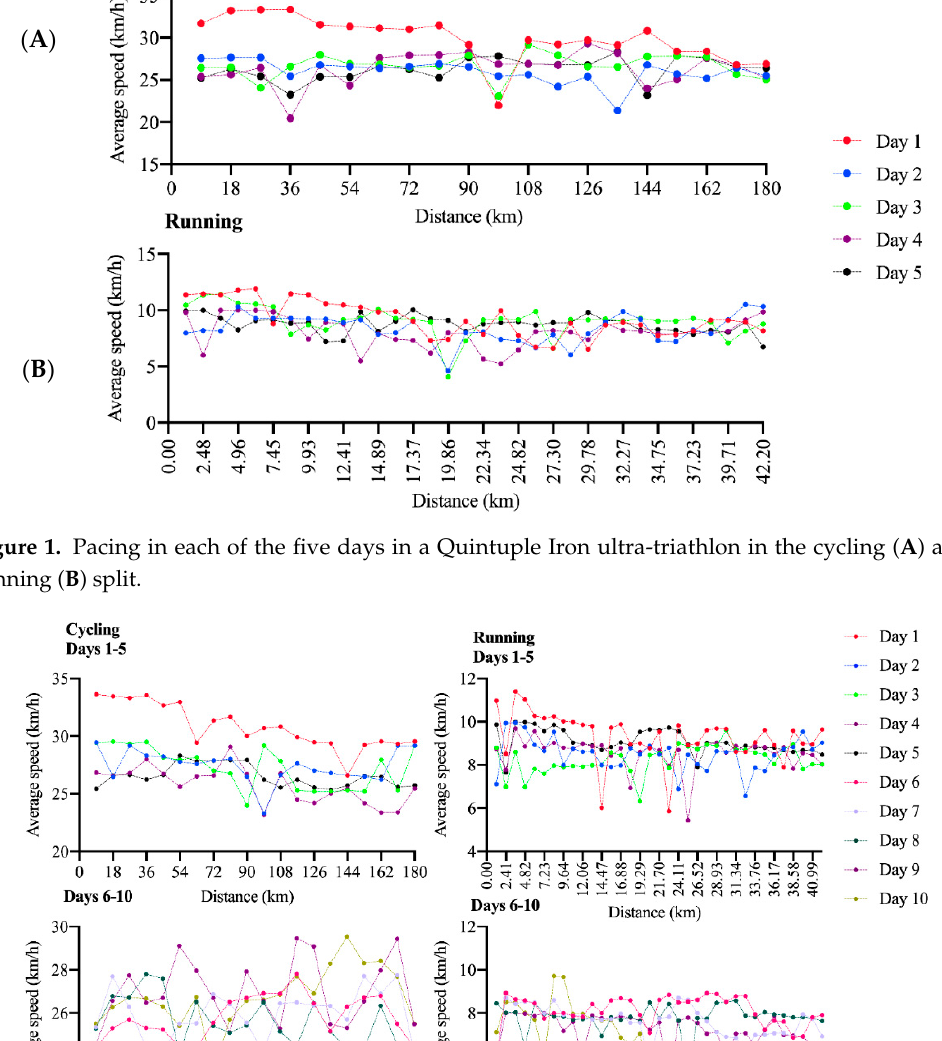
cycling and 42.195 km of running.